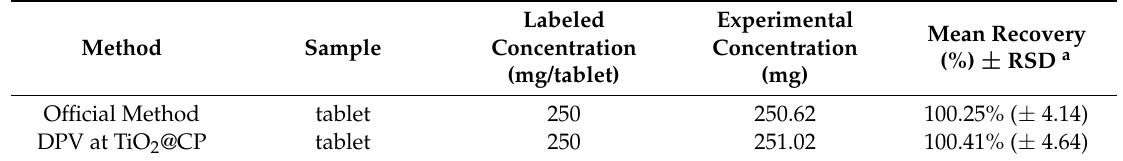
Table 5. Results obtained for the determination of methyldopa in commercial pharmaceutical formulations (tablets) using the proposed DPV method and official method